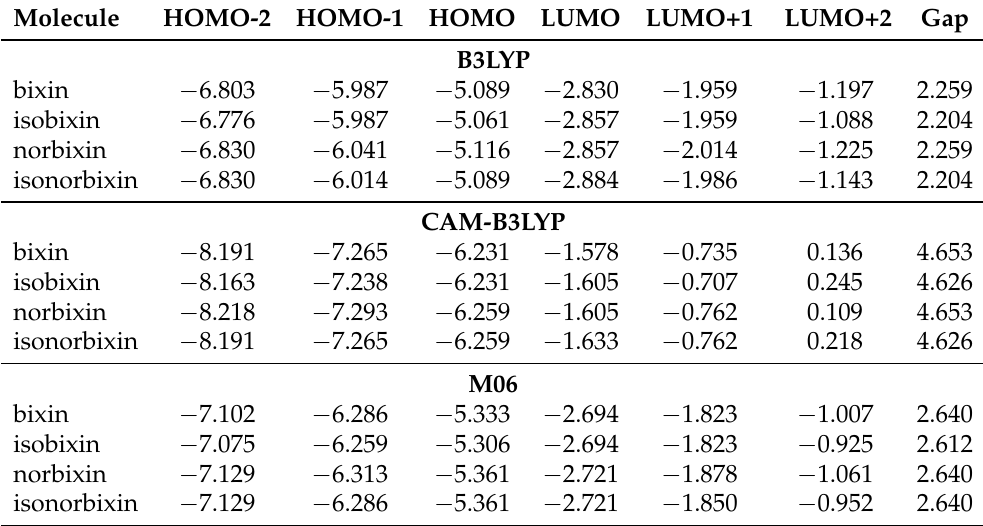
Table A8. Frontier MOs and gap energy values for the dyes in gas phase. These results were obtained by employing the 6-31G(d,p) basis set. All values are in electron-Volt (eV).